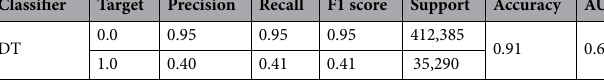
Table 3. Metrics for the first